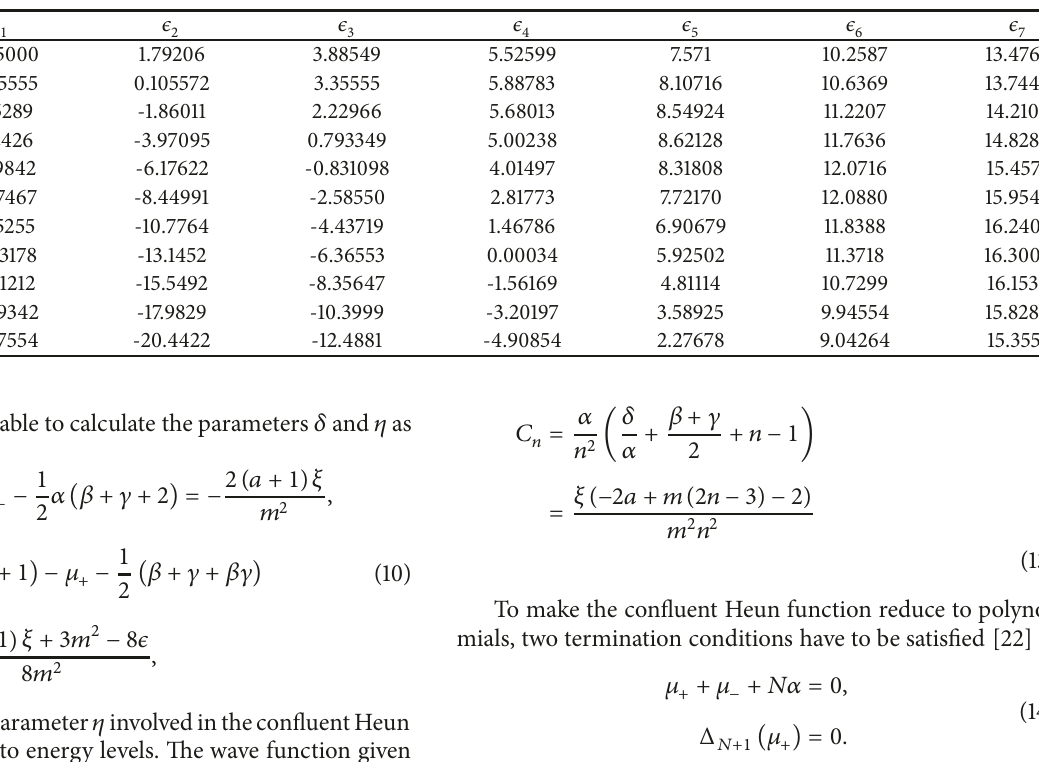
Table 1: Spectra of the Schr¨odinger equation with potential